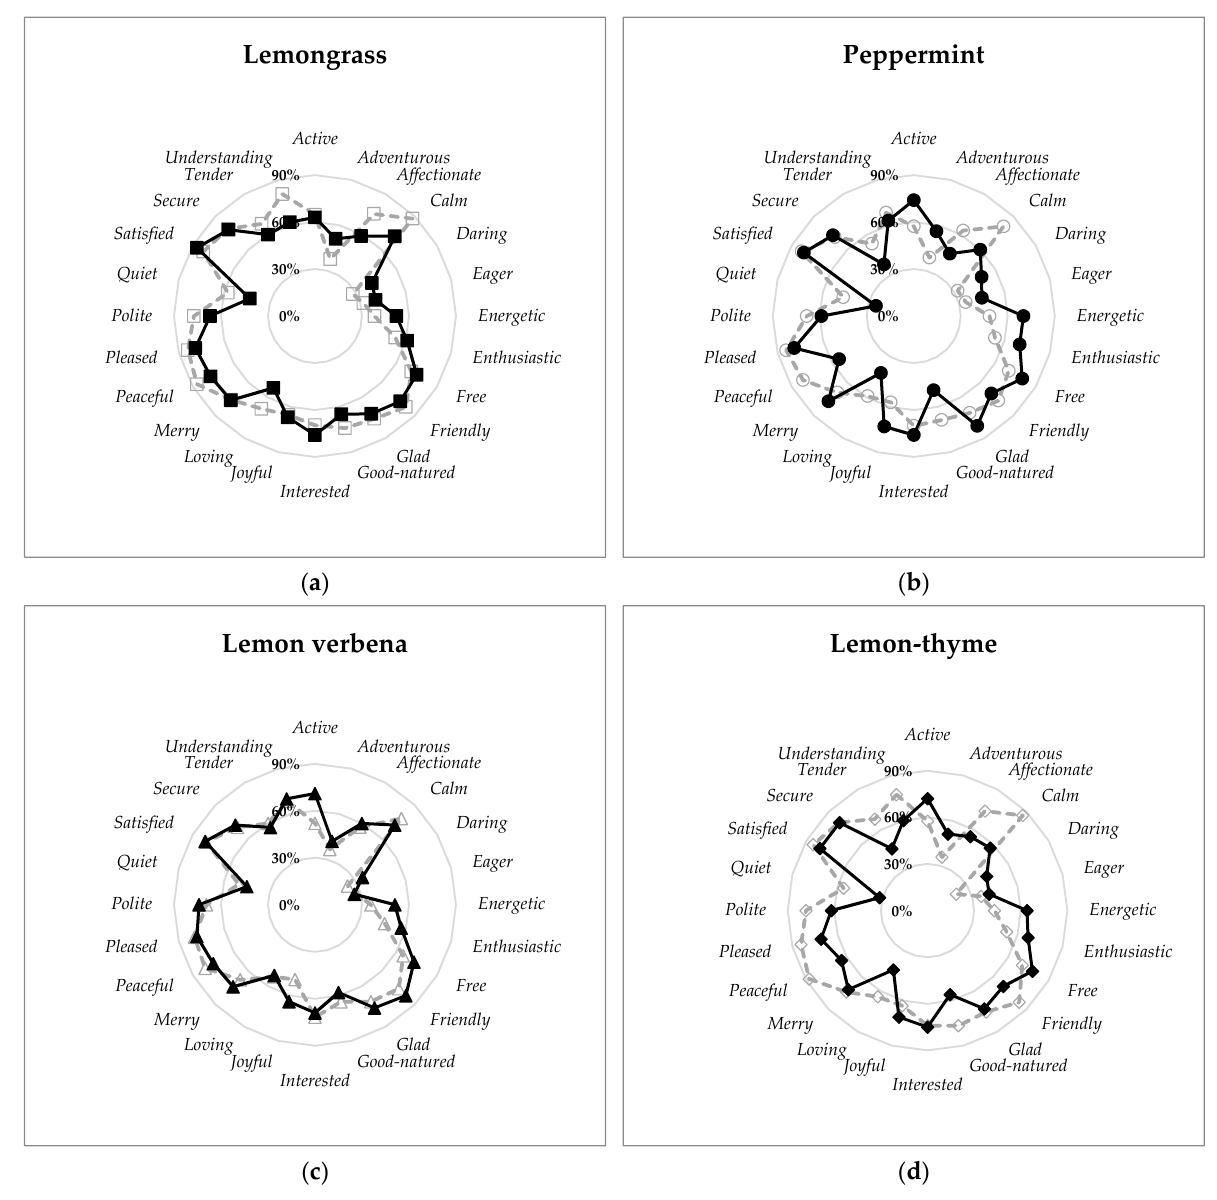
Figure 5. The emotional profile of the samples ( a ) lemongrass; ( b ) peppermint; ( c ) lemon verbena; and ( d ) lemon thyme from the evaluation with the original list terms (continuous line) and the one with the adapted list which intended to assess the impact of the harvesting conditions, of the average of treatments (dotted lines).